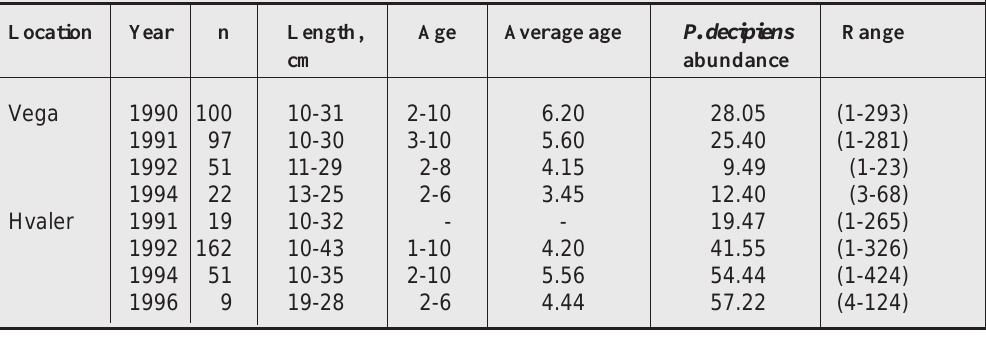
Table 1. Numbers and age distribution of sculpins examined, and abundance of P. decipiens. Prevalence varied between 90% and 100%.